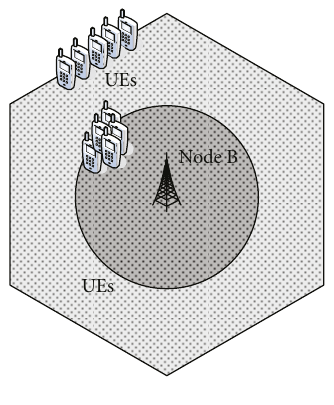
Figure 6: MBMS provision with rate